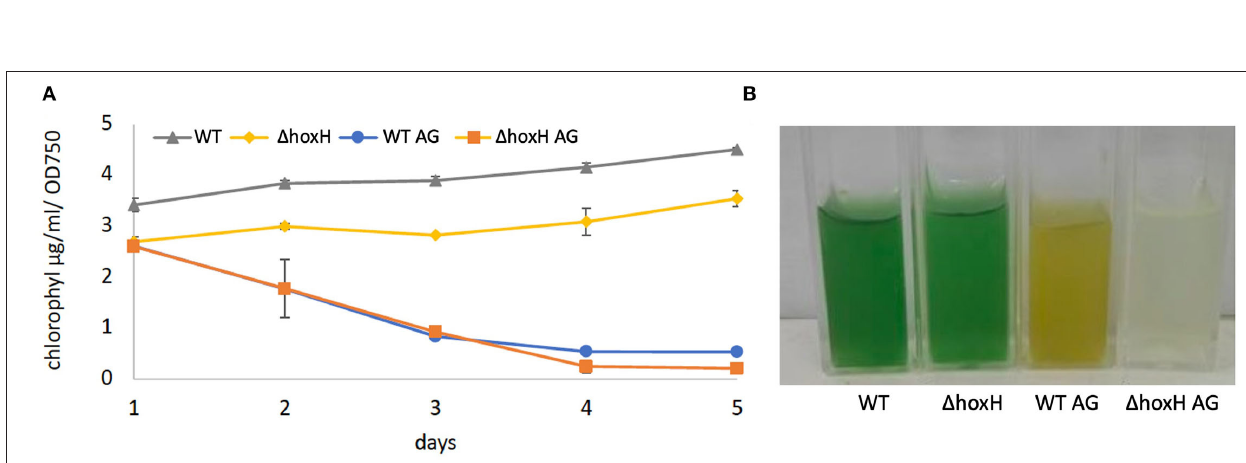
Frontiers in Microbiology |